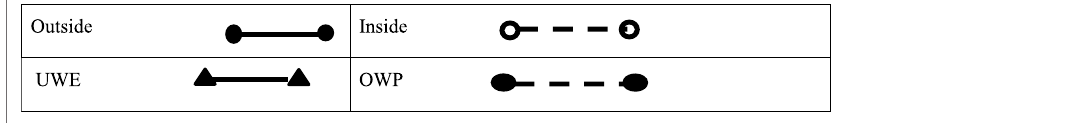
FIGURE 6 | (A) Monthly average air temperature ( ° C), recorded by weather station, at Oldwood Pit inside and outside the rainfall shelters; (B) Monthly average of midday photosynthetically active radiation (PAR) in µmol of photons m − 2 s − 1 at Oldwood Pit (OWP), measured and under the roof and outside the rainfall shelters; (C,D) Difference in monthly average soil temp ( ° C), from Degagon MPS6 sensor, at 10 cm between Reduced Rainfall and Control plots at (C) UWE and (D) OWP. Average temperatures were calculated from daily maximum and daily minimum